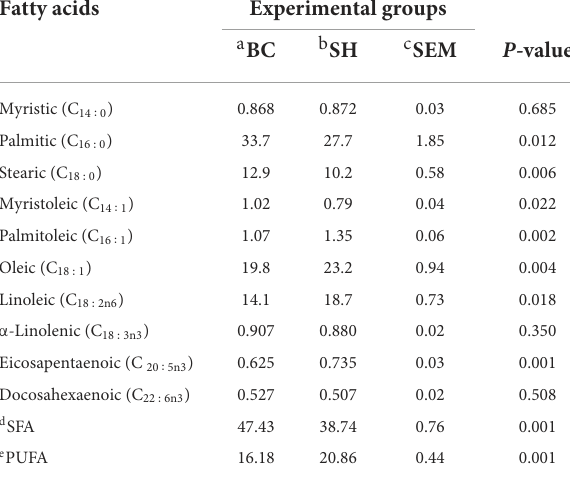
TABLE 3 Fatty acids profile (g 100 g − 1 ) of breast muscle in broiler chickens and spent laying hens.